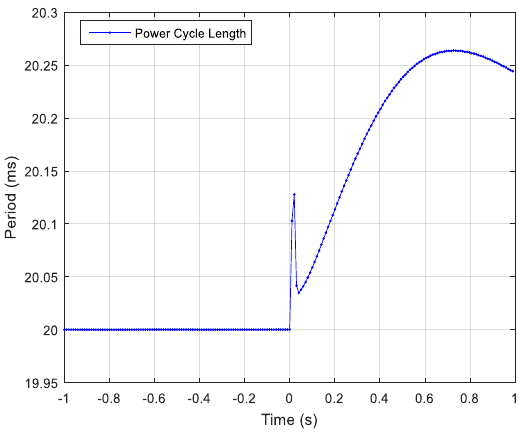
Figure 3. Voltage cycle length before and after islanding.